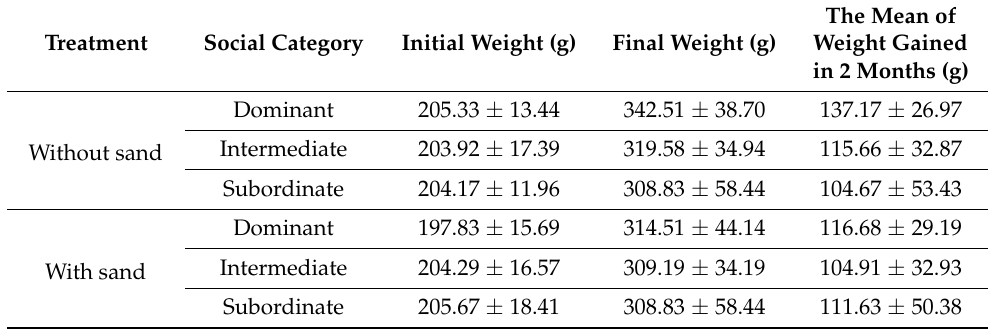
Table 3. Growth parameters in Senegalese sole of dominants ( n = 6), intermediates ( n = 12) and subordinates ( n = 6) without sand and dominants ( n = 6), intermediates ( n = 12) and subordinates ( n = 6) maintained with sand. Data are shown as mean ±